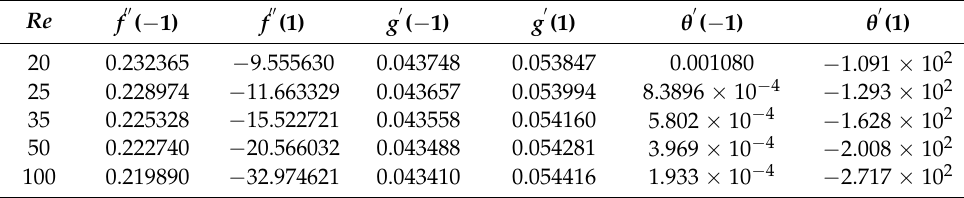
Table 4. Shear stresses, couple stresses, and heat transfer rate for different Re .